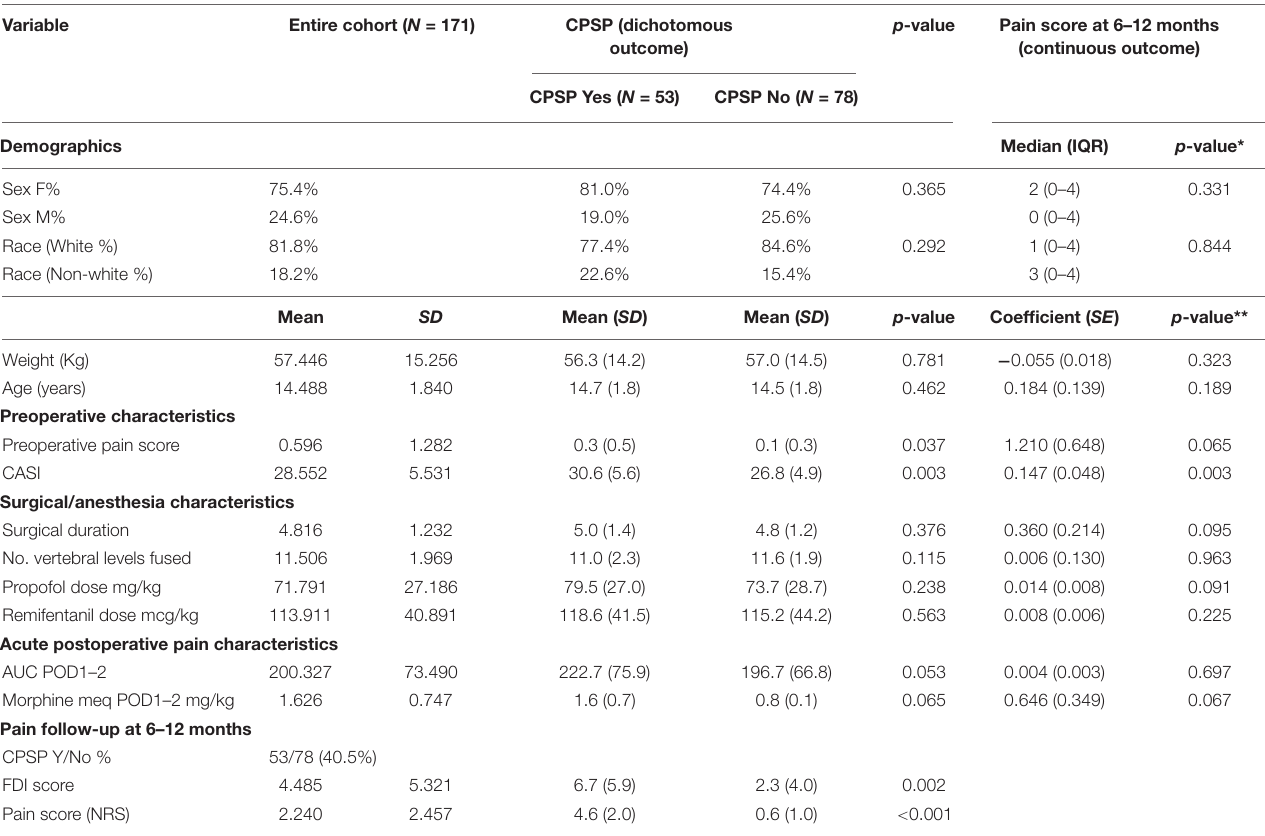
TABLE 1 | Baseline and pain follow-up characteristics of the surgical cohort, based on chronic post-surgical outcomes and univariate analyses of perioperative/psychological covariates.